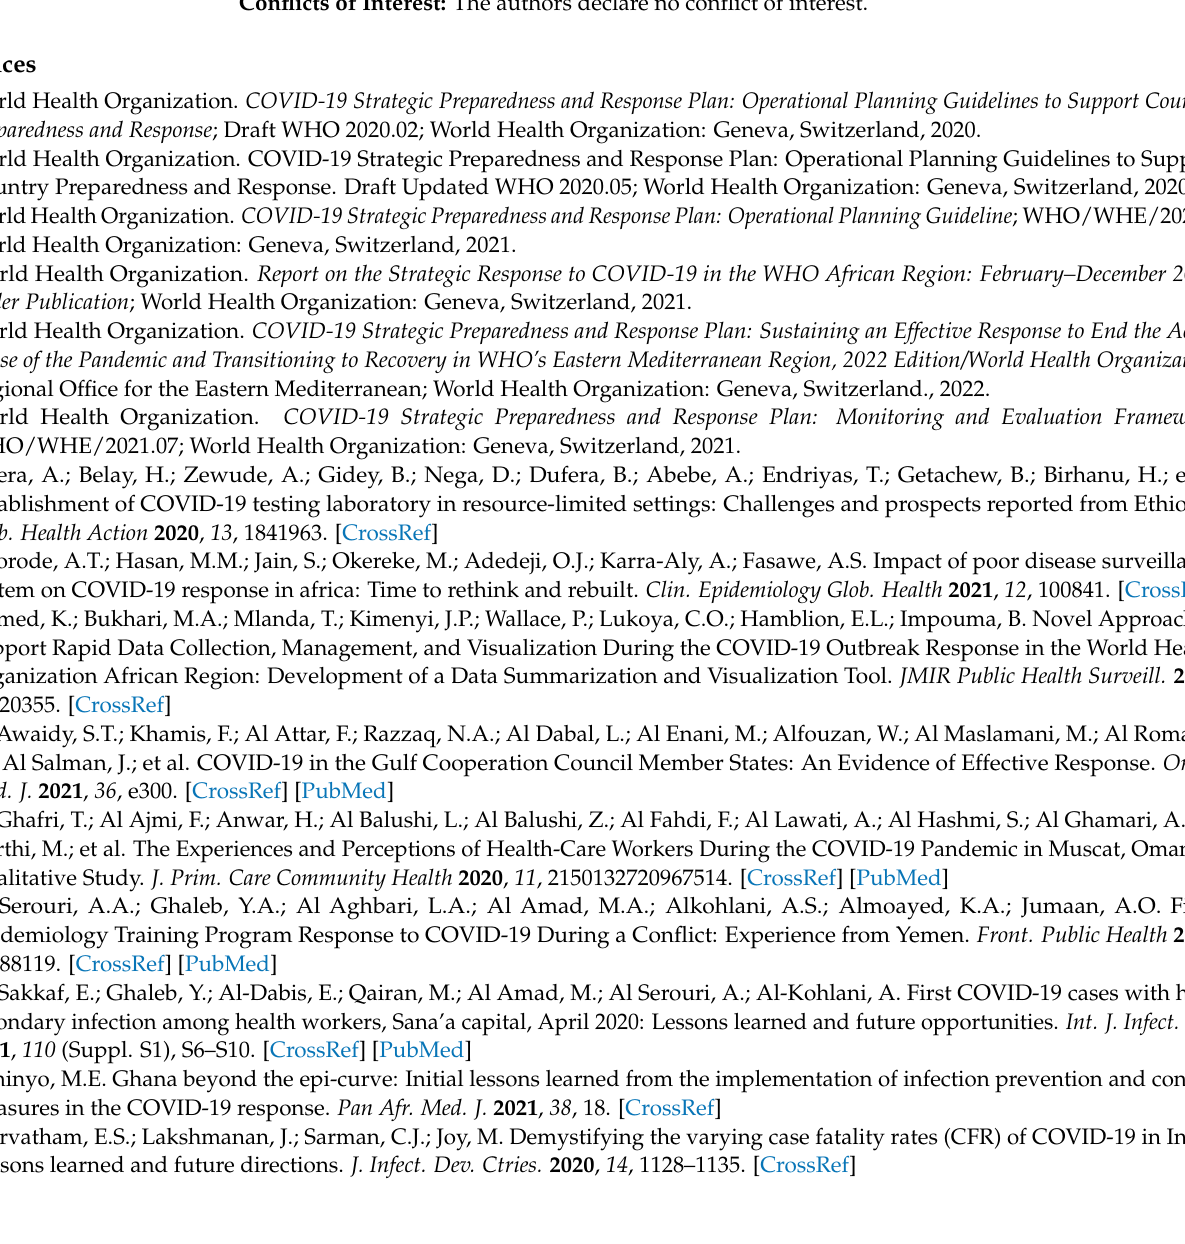
10—Ranking of lessons learned and number of their citations in papers from different WHO regions; Table S1: Studies included and corresponding WHO pillars public health